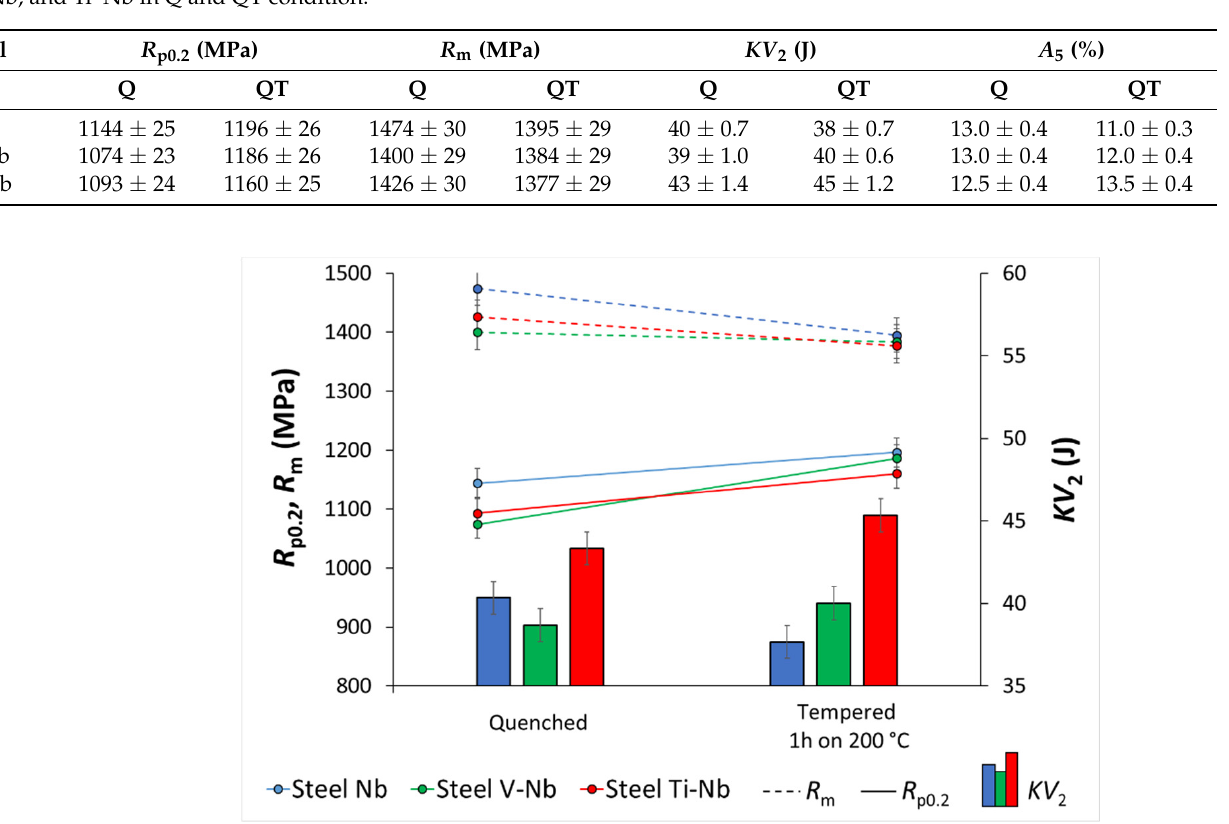
Table 3. Yield strength ( R p0.2 ), tensile strength ( R m ), impact toughness at − 40 °C ( KV 2 ) and elonga- tion ( A 5 ) for steel Nb, V–Nb, and Ti–Nb in Q and QT condition.